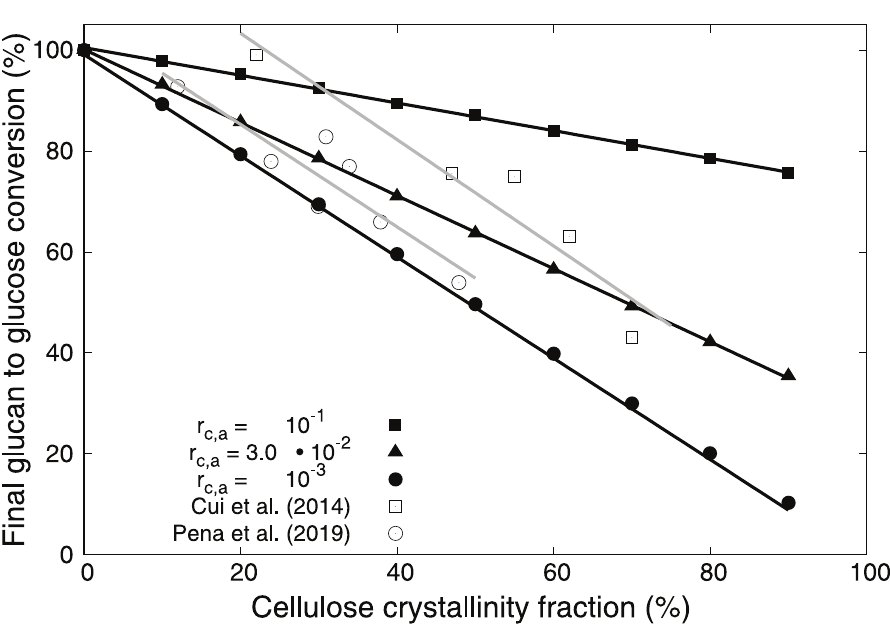
Fig 8. Simulated final glucan to glucose conversion versus crystallinity fraction for different ratios ( r c,a ) between the digestibilities of the crystalline and the amorphous regions. For each value of r c,a we observe a linear decrease in final glucan to glucose conversion percentage for increasing crystallinity fraction, whose slope becomes steeper as r c,a decreases. For r c,a = 10 − 3 we observe inverse proportionality in addition to linearity. Each simulated point represents an average over 100 simulations. Also shown are experimental data by Cui et al. [71] (empty squares) and Pena et al. [72] (empty